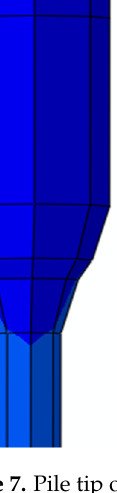
Table 1. Parameters of soil and pile.